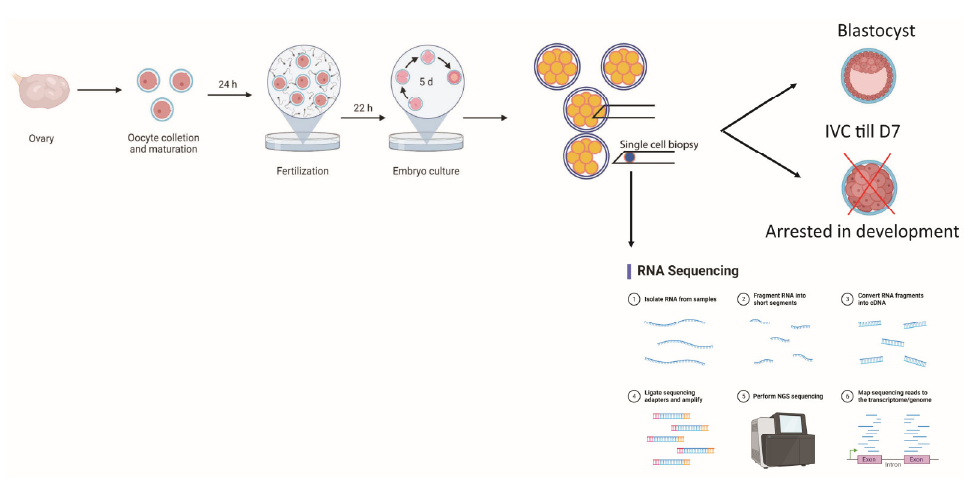
Figure 1. Summary of the experimental design.